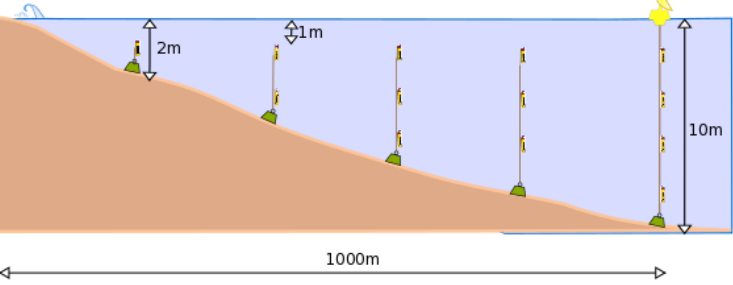
Figure 15. Network deployment at the